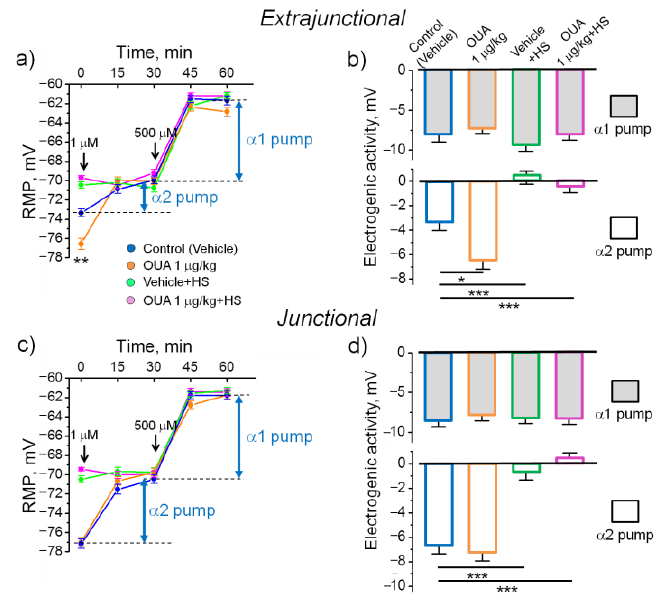
Figure 2. The effects of a single injection of ouabain prior to HS. The resting membrane potential (RMP) ( a , c ) and electrogenic contributions of the α 1 and α 2 Na,K-ATPase ( b , d ) in rat soleus muscles after 6 h of HS. The measurements were done in extrajunctional ( a , b ) and junctional ( c , d ) sarcolemma regions. Injection of either ouabain (1 µ g/kg) or vehicle 0.9% NaCl was done immediately prior HS. The results were compared to 6-h measurements after vehicle (control) or 1 µ g/kg ouabain injections (both without HS). The electrogenic contribution of the α 2 and α 1 Na,K-ATPase was estimated by administration of 1 µ M or 500 µ M ouabain (indicated by the corresponding arrows). Each data point corresponds to the averaged RMP measured in at least of 100 muscle fibers of 6–10 muscles from 3–5 rats. Two-way ANOVA followed by Tukey’s multiple comparisons test. ( a ) ** p < 0.01—RMP value compared to the corresponding control. ( b , d ) * p < 0.05, *** p < 0.001—compared as indicated by horizontal bars.